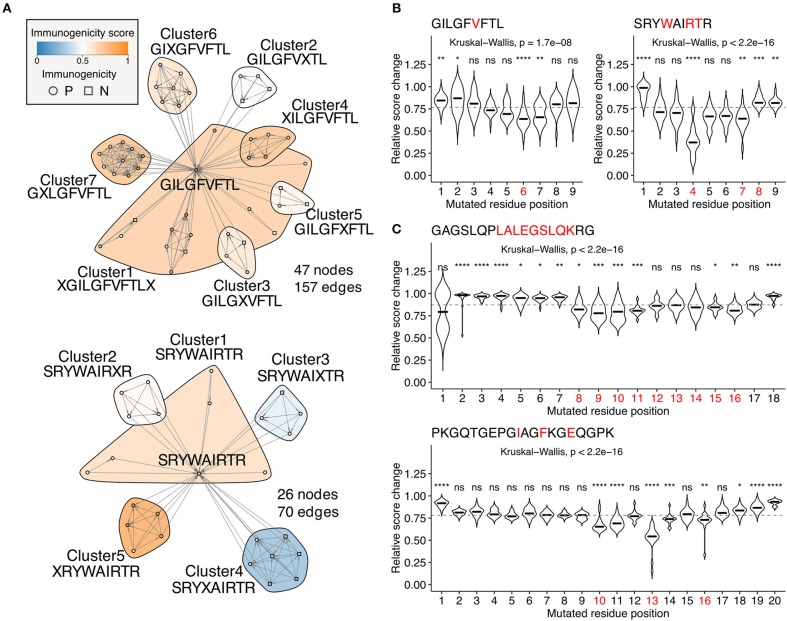
Identification of escape-prone positions from in silico mutagenesis and neighbor network analysis. (A) Example neighbor networks of MHC-I-restricted influenza A virus epitopes GILGFVFTL and SRYWAIRTR and their observed neighbors. Consensus sequences are indicated below the cluster IDs. (B,C) Relative score changes estimated from all possible simulated neighbors for (B) MHC-I-restricted influenza A virus epitopes GILGFVFTL and SRYWAIRTR and (C) MHC-II-restricted insulin-derived epitope GAGSLQPLALEGSLQKRG and collagen-derived epitope PKGQTGEPGIAGFKGEQGPK. Red letters indicate residues known to have escape mutations shown by in vitro T cell assays from the literature. Representative peptides were chosen based on their high immunogenicity scores with manual literature inspection. ns, not significant; *P < 0.05; **P < 0.01; ***P < 0.001; ****P < 0.0001.